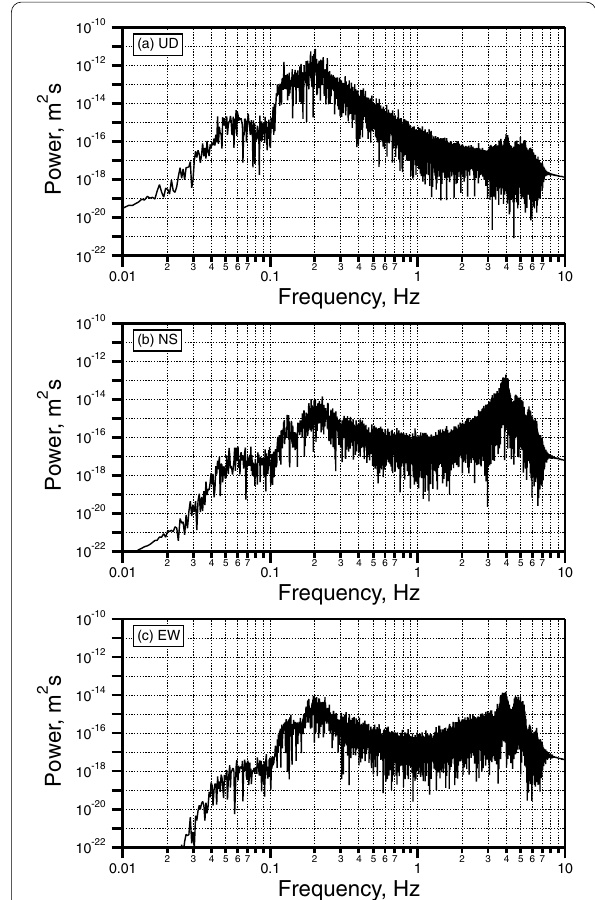
Fig. 8 Power spectra for the displacements of the superconducting sphere. These have been derived by convolving theoretical responses of horizontal and vertical components with the ground motions recorded by a seismometer. a Up-down component. b North–south component. c East–west